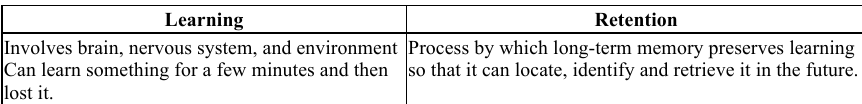
Table 3. Learning versus